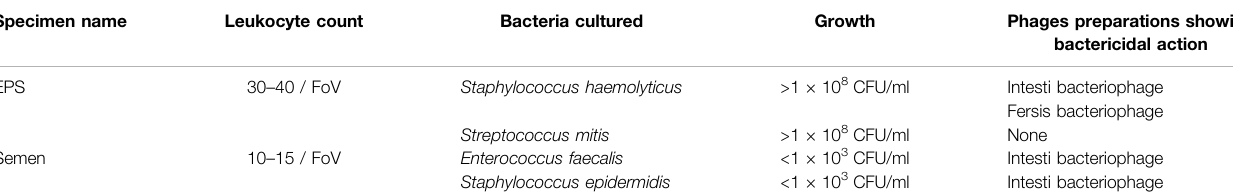
Table 2 | Results of analysis and cultures of fl uids from the infected region — March 2017.